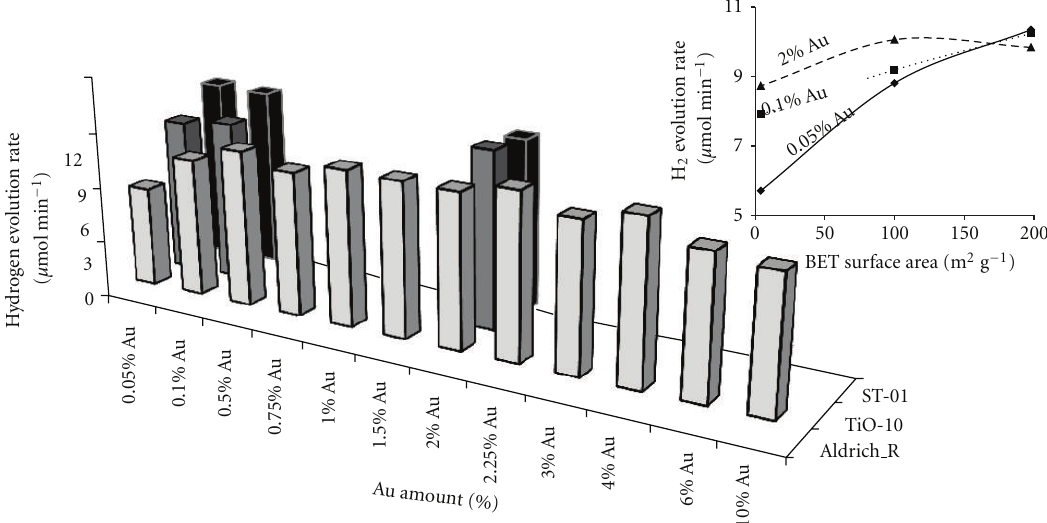
Figure 6: Influence of gold amount on methanol dehydrogenation during photodeposition on three titania photocatalysts: ST-01, TIO-10, Aldrich R (under UV/vis with mercury lamp). Inset. Dependence of hydrogen evolution on BET surface area (198, 100, and 4m 2 g − 1 for ST-01, TIO-10, and Aldrich R, resp.) for three amounts of gold used for deposition: 0.05, 0.1, and 2wt%.